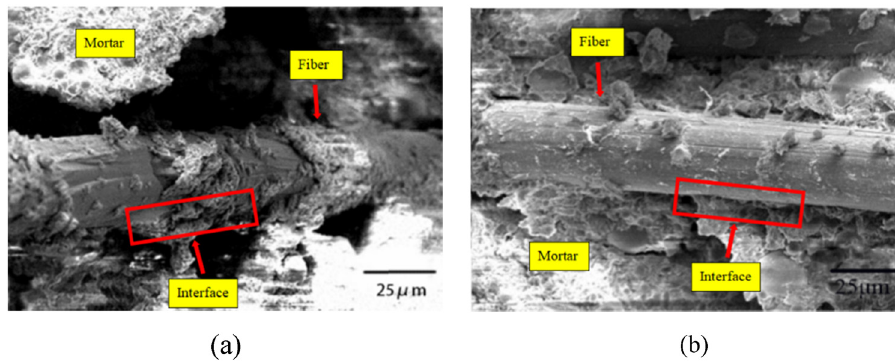
Figure 14: The SEM images of PVA fi ber after sulfate attack for 60 days. ( a ) Untreated and ( b ) oiled.